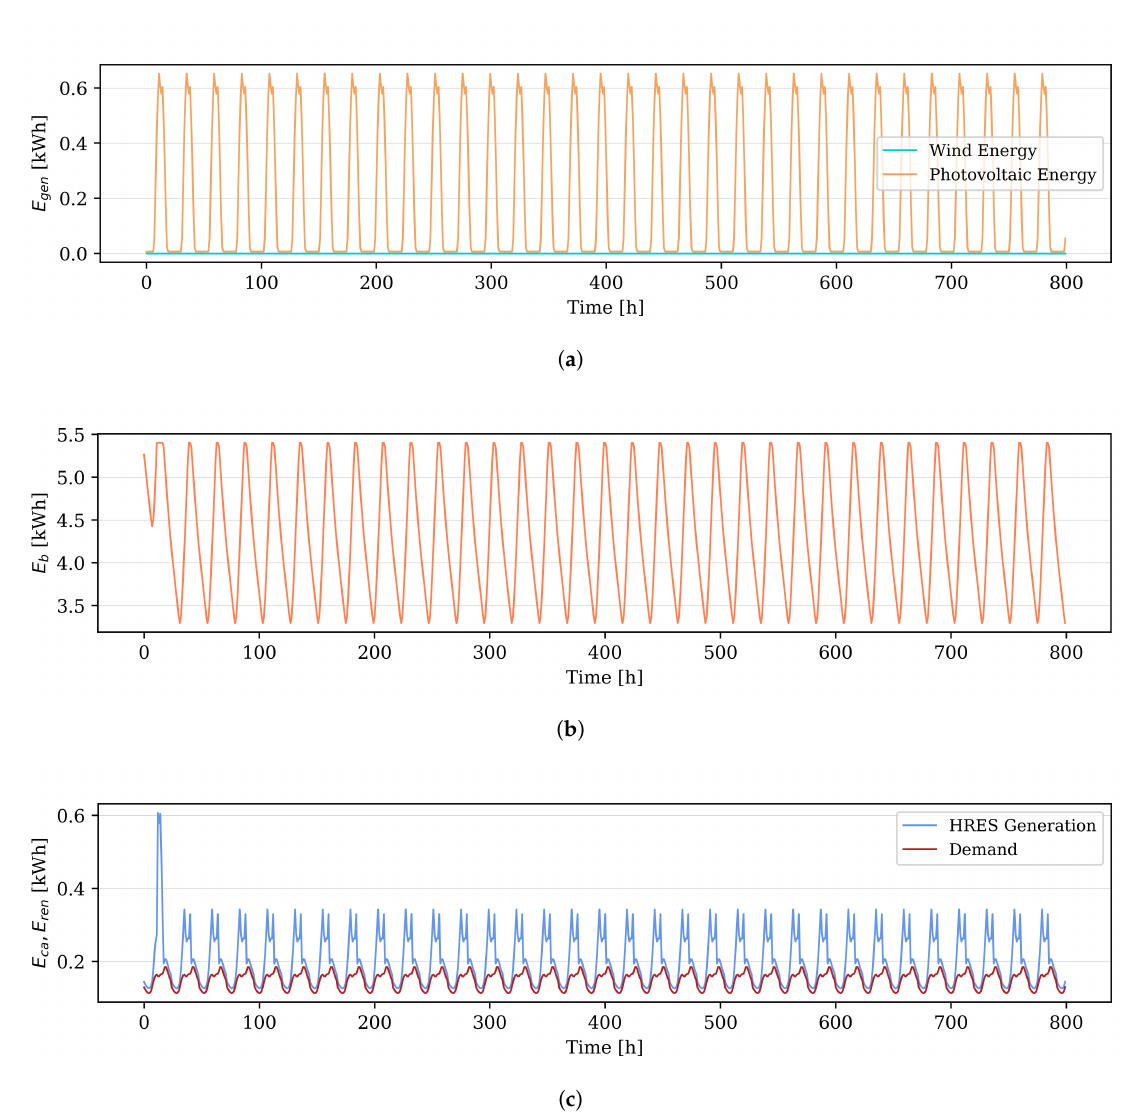
Figure A2. Profiles of best HRES configuration for non-interconnected zone (3.6 kW-h/day) obtained by multi-objective function with TAC , N pv ,1 = 6, N pv ,2 = 1, N b = 4. ( a ) Total renewable energy generation. ( b ) Storage system state. ( c ) HRES generation vs.